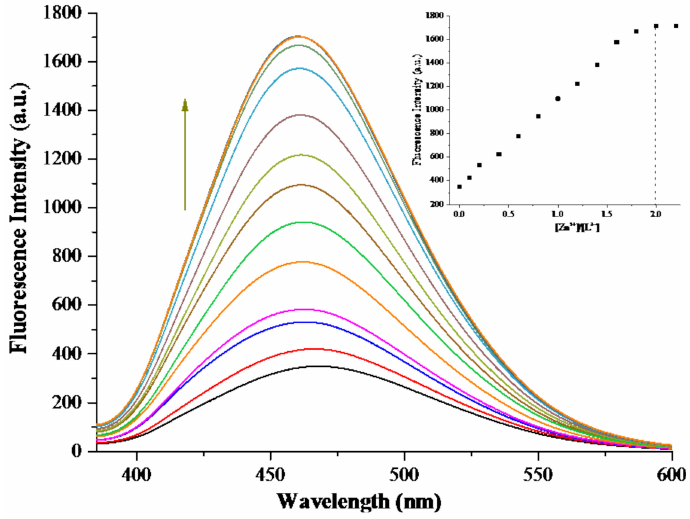
Figure 8. Fluorescence spectrum changes of H 3 L (c = 1 × 10 − 5 M, λ ex = 370 nm) solution upon addition of different amounts of Zn II